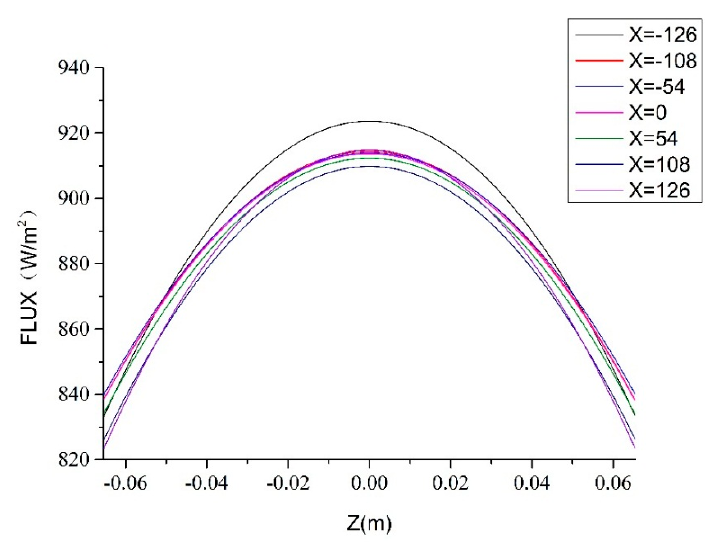
Figure 20. Fitting curves of heat fluxes at different location.